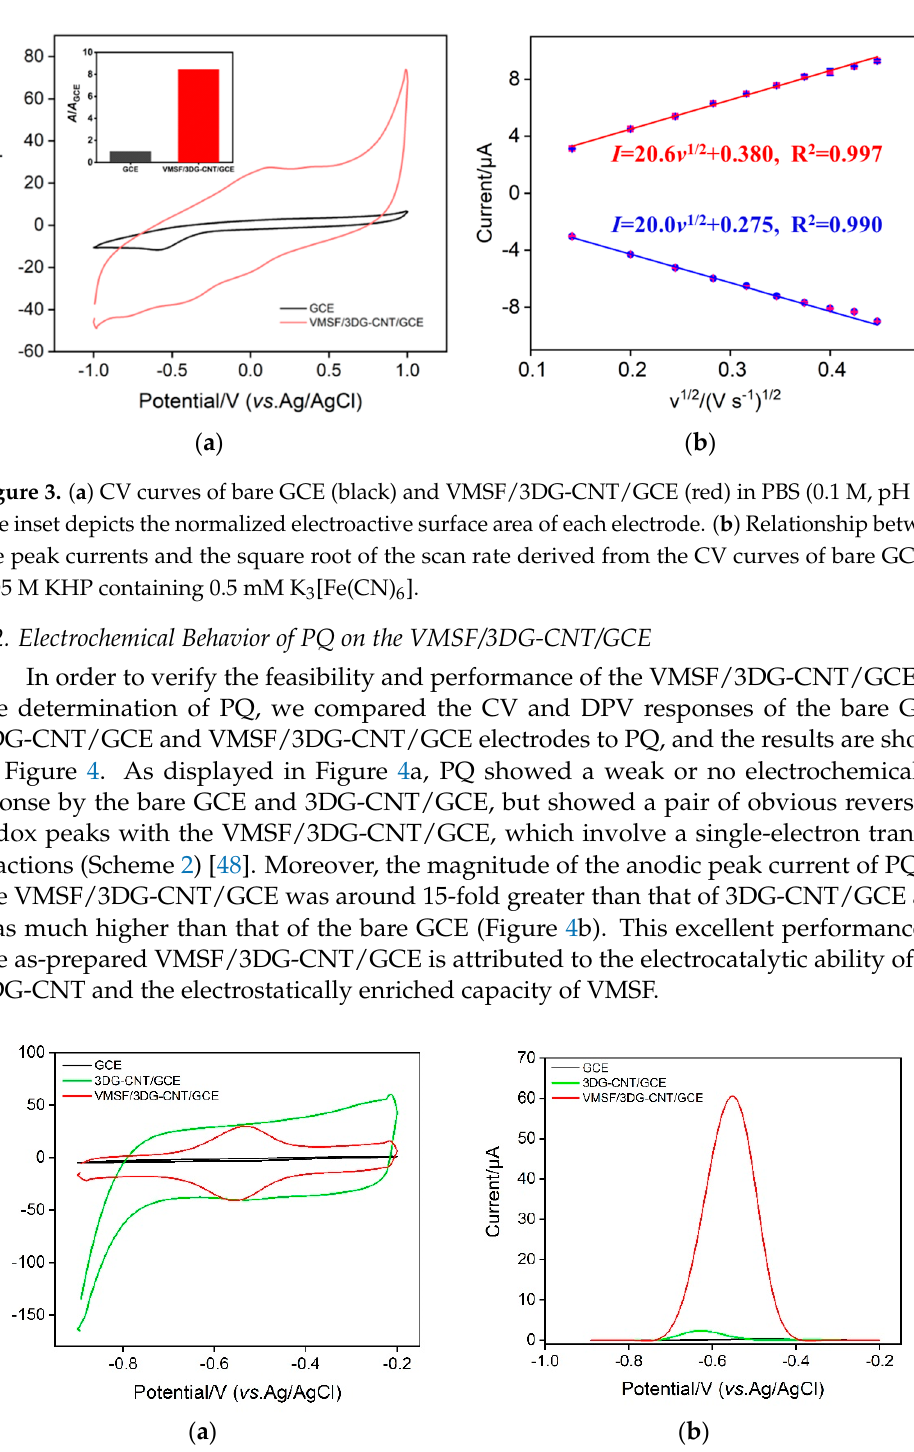
Figure 4. ( a ) CV and ( b ) DPV curves obtained with different electrodes in 0.1 M PBS (pH = 6) containing a 10 µ M PQ solution.